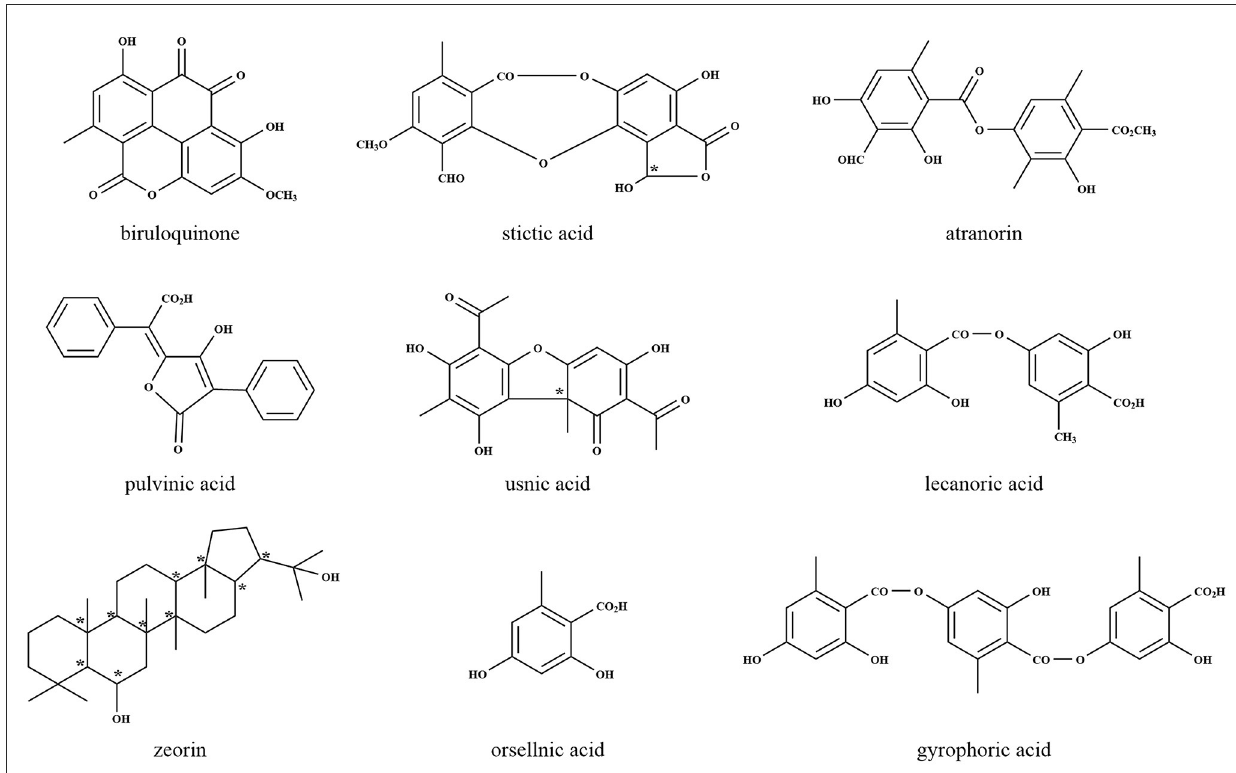
FIGURE2 Representative lichen metabolites derived by LFF. *Indicates the chiral